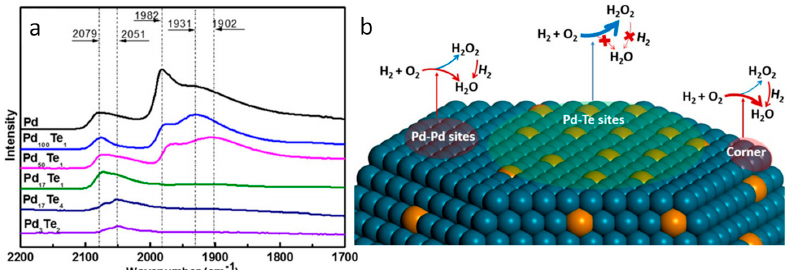
Figure 13. ( a ) In situ DRIFTS measurement of CO adsorption over the Pd–Te/TiO 2 catalysts at 283 K in an Ar flow. ( b ) Proposed mechanism for the direct synthesis of H 2 O 2 over Pd–Te/TiO 2 catalysts. Blue and brown spheres are Pd and Te atoms, respectively. Reprinted from P. Tian, X. Xu, C. Ao, D. Ding,